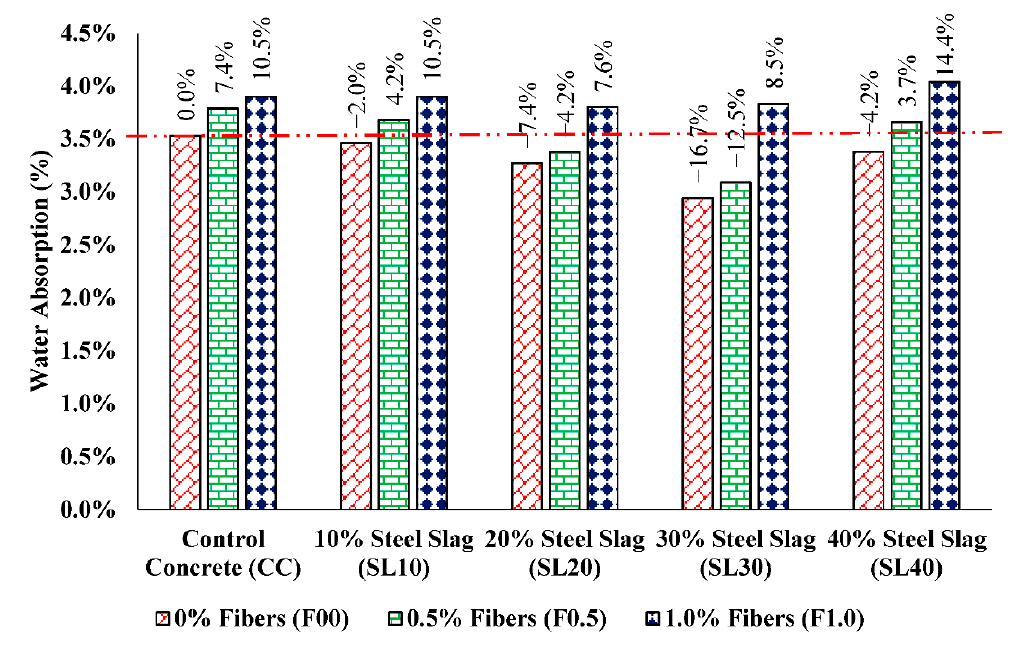
Figure 12. Comparison of water absorption results for all mixes.